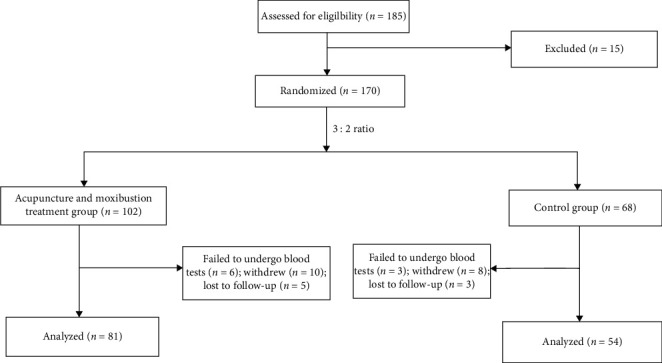
Low chart of participants.